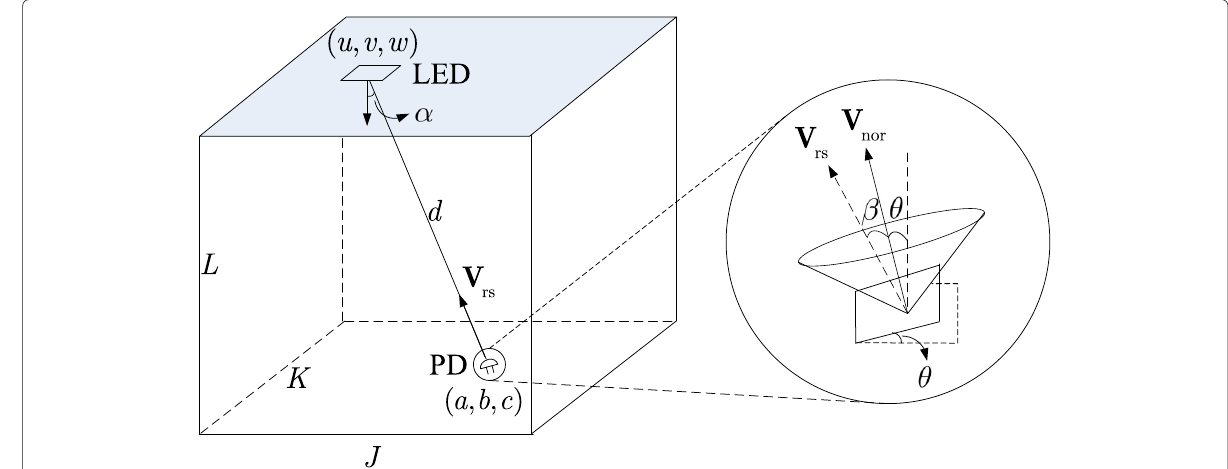
Fig. 1 A classic point-to-point indoor VLC